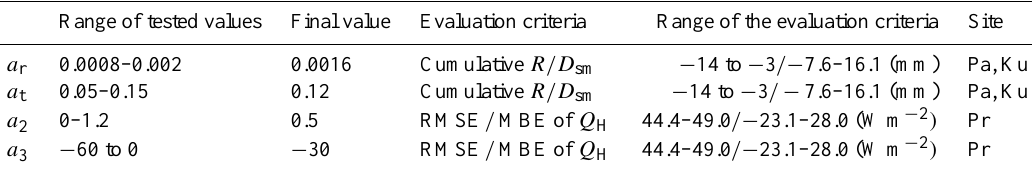
Table 3. Results of the model optimization made for the snow storage heat and meltwater calculations. Different evaluation criteria for the components were used. See text for further explanation.